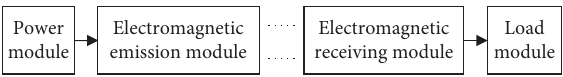
Figure 2: Structure diagram of MCRWPT system.